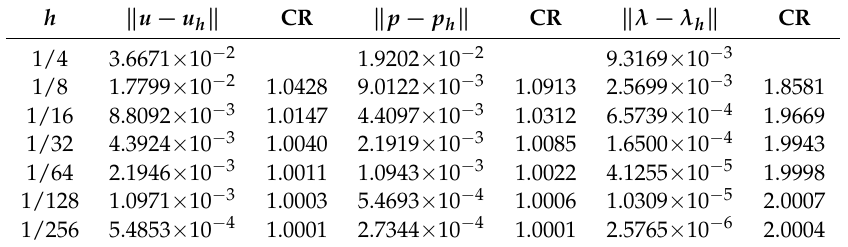
Table 4. Discrete errors and convergence rates for Example 1 at time T = 1 with δ t = 0.1 and nb = 4.